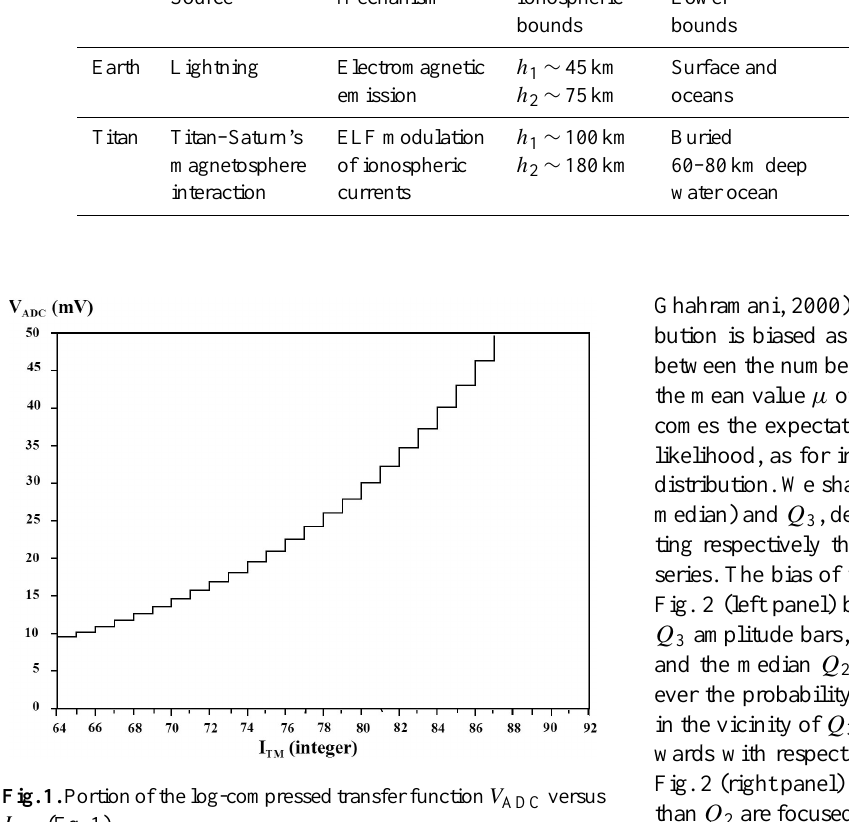
Table 1. Comparison of peculiarities of the Schumann resonances on Earth and Titan (after Béghin et al., 2012). Source